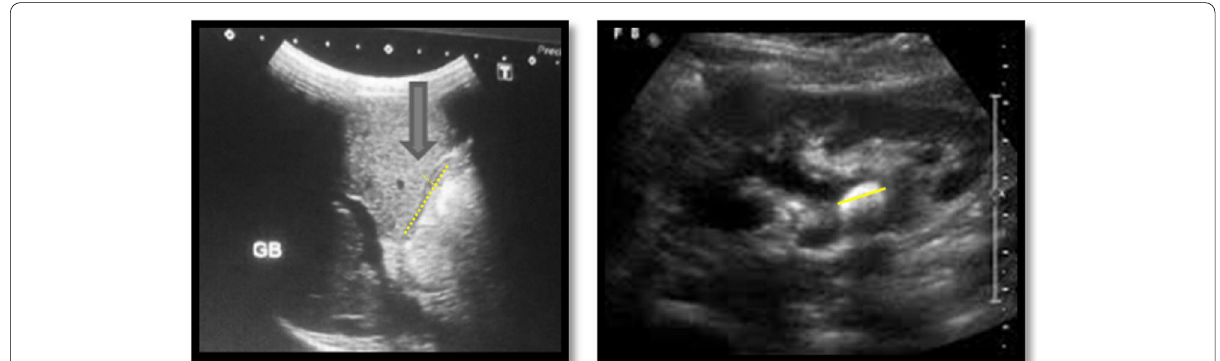
Fig. 1 A child known to have cystic fibrosis. He was complaining of chronic cough and recurrent abdominal pain. His labs are as follows: ALT, 19; AST, 24; Na, 128; K, 3.5; and random blood glucose, 90. Ultrasound of the abdomen shows heterogeneous liver parenchyma but with normal size, micro-gall bladder (arrow) measuring about 0.4 1.5 cm, right renal calculus measuring about 9 mm with mild back pressure ×